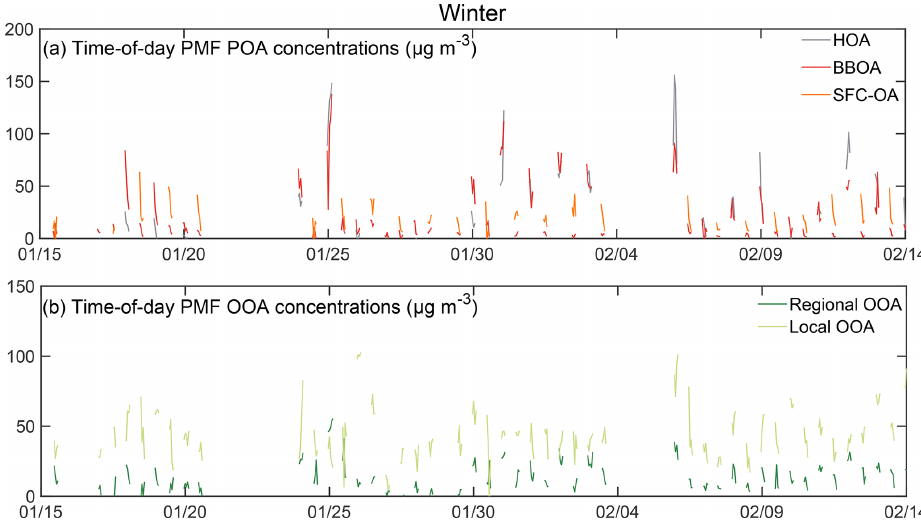
Figure 1. Hourly averaged seasonally representative concentration time series of time-of-day PMF (a) primary and (b) secondary factors for winter 2017 (in µgm − 3 ) . POA PMF factors show stronger variability than OOA PMF factors. (Chopped lines are due to the analysis conducted on two 4h periods each